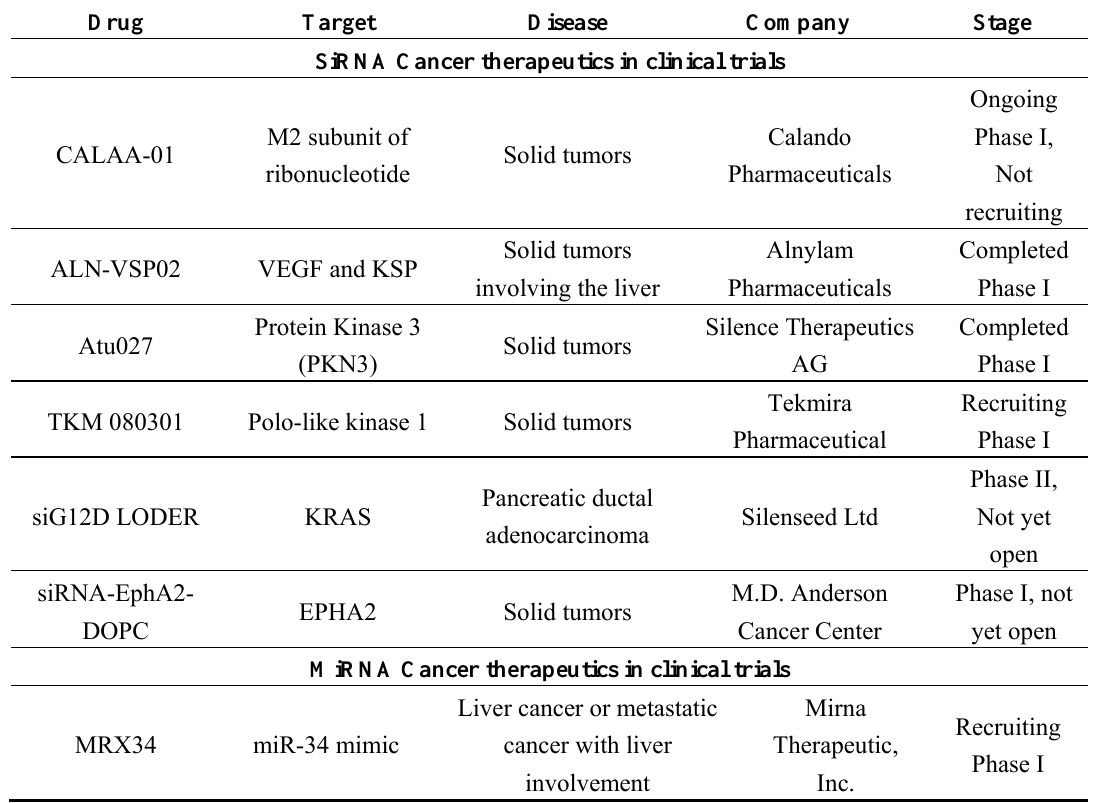
Table 1. SiRNA/miRNA Cancer therapeutics in clinical